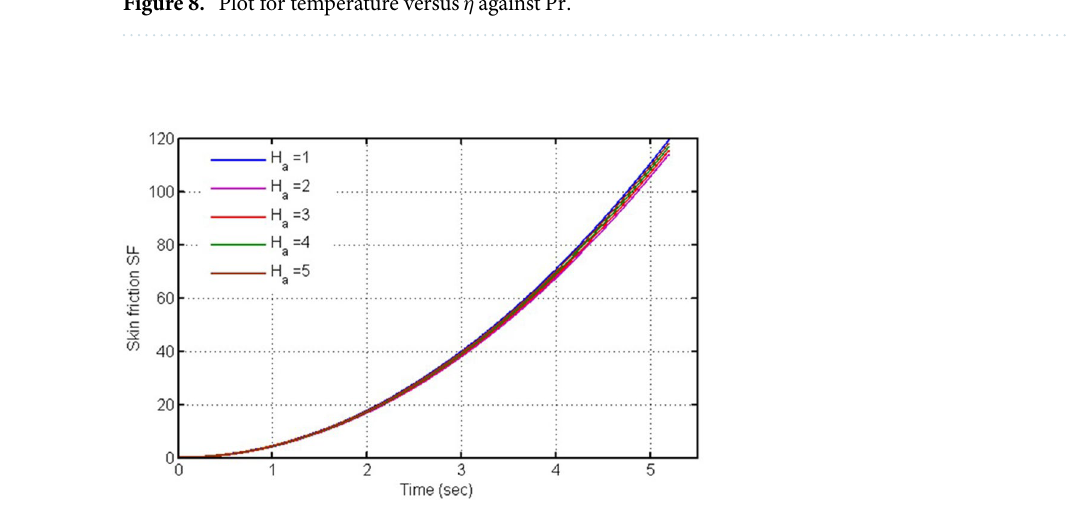
Figure 8. Plot for temperature versus η against Pr.